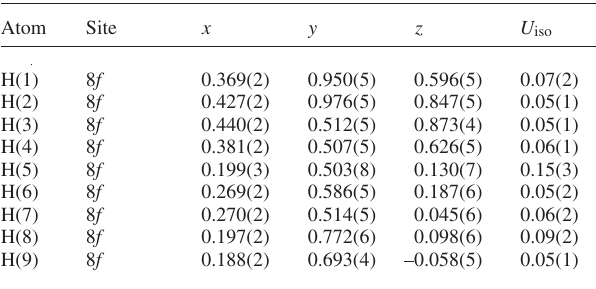
Table 2. Atomic coordinates and displacement parameters (in Å 2 )